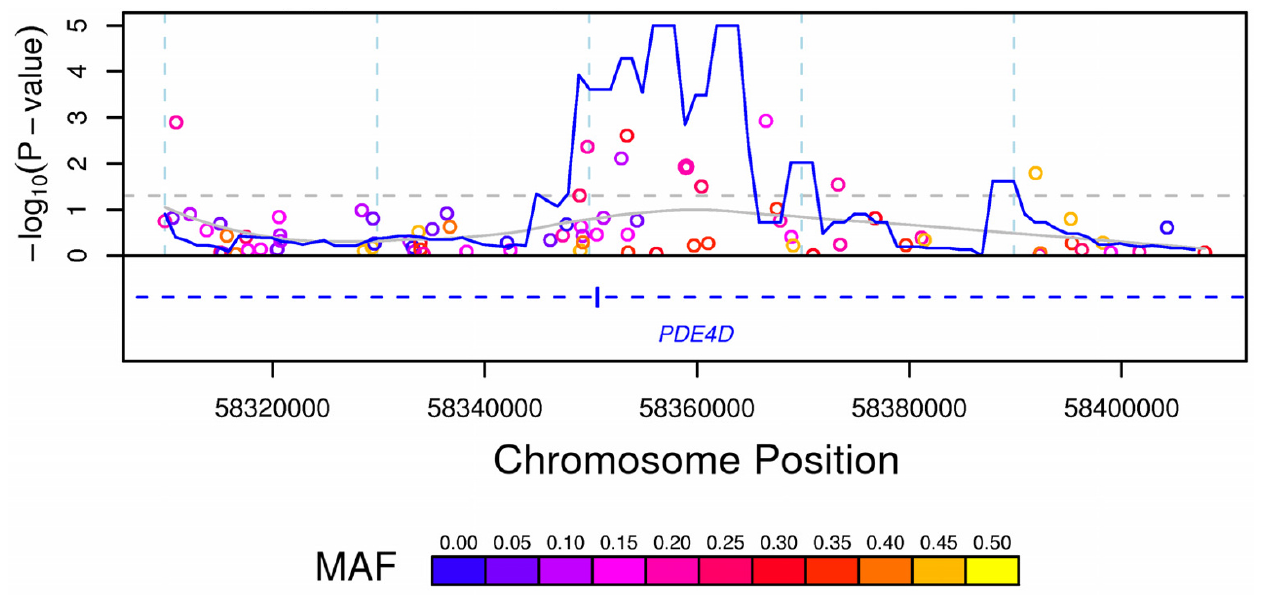
Association fine mapping of PDE4D region Figure